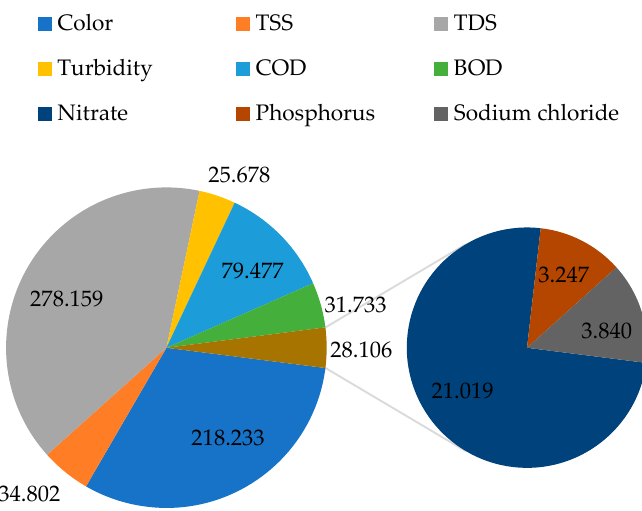
Figure 5. The estimated adsorption capacity of the filter material (mg/g).